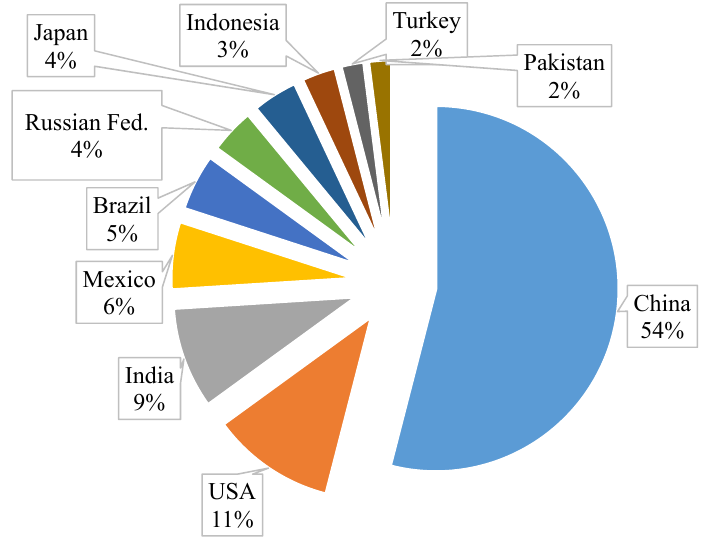
Figure 2. Global pie chart of eggs produced annually in 2017. Table 1. Annual egg production by the top 10 countries in 2017 (* values multiplied by 1000).